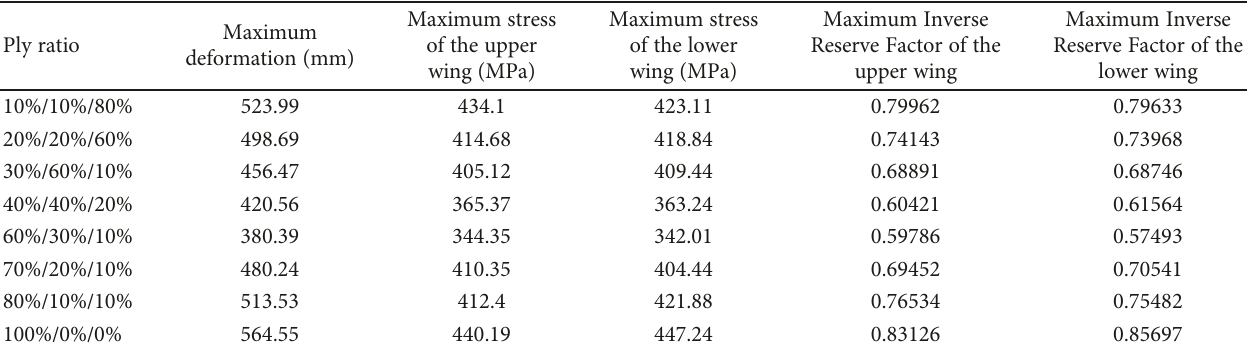
Figure 58: Stress cloud diagram of the lower wing with the layer ratio being 80%/10%/10%. Table 8: Structural performance of di ff erent ply